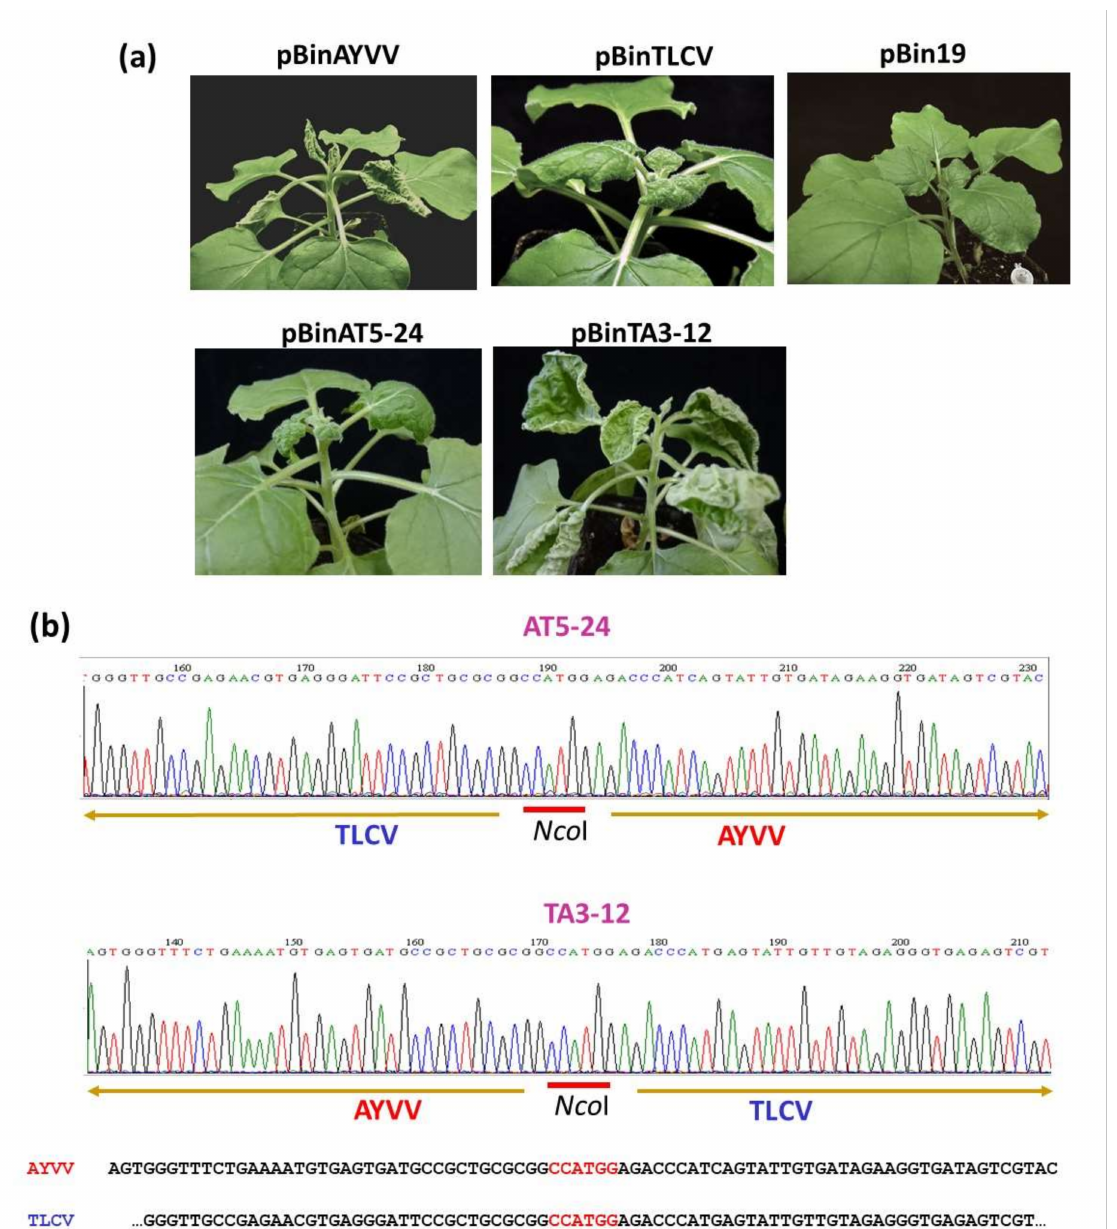
Figure 3. Symptoms induced by various infectious clones of wild-type or chimeric begomoviruses on Nicotiana benthamiana . ( a ) Agrobacterium tumefaciens cells harboring infectious clones of various begomoviruses were infiltrated into N. benthamiana . The symptoms were recorded at 21 days post inoculation (dpi). ( b ) Representative sequencing chromatograms for the analysis of the progenies of the recombinants. To verify the maintenance of the recombination in the progenies, total DNA was extracted from the upper leaves, amplified by RCA, cloned, and sequenced. The nucleotide sequences flanking the NcoI recombination site (indicated by the red bar) were presented. pBin19: empty vector control; pBinAYVV: AYVV-NT wild-type; pBinTLCV: TLCV-TC wild type; pBinAT5-24: chimeric AYVV carrying TLCV C4 gene; pBinTA3-12: chimeric TLCV carrying AYVV C4 gene. The nucleotide sequneces originating from AYVV-NT or TLCV-TC were indicated by the arrows underneath. The original nucleotide sequences of AYVV-NT and TLCV-TC corresponding to those shown in the sequencing chromatograms were shown at the bottom for